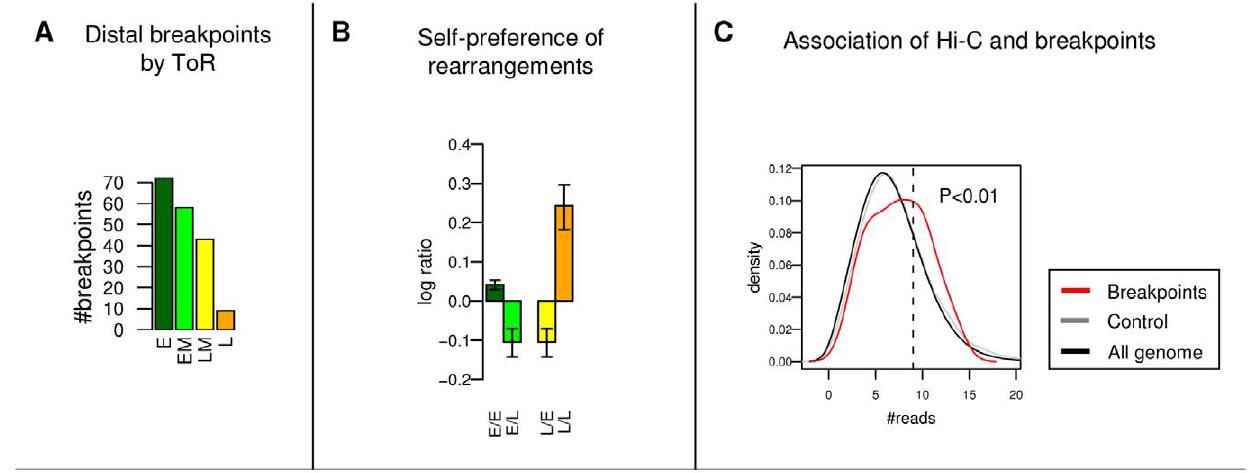
Figure 5. ToR and Hi-C preferences of distal rearrangements. (A) Distal fusion events involve early replicating domains. Each distal murine fusion event (inter-chromosomal or spanning at least 5MB in all non-rodent species) is associated with 2 human ToR groups (of the two segment ends that got fused). We show the breakdown of fusion events according to ToR groups. (B) Distal fusion events bring together domains with similar ToR. We split the genome to two equal groups (E:early, L:late), and counted for all murine distal fusions the number interaction of all possible pairs (E- E, E-L, L-L). We show the ratio between the counts and a random control (log 10 scale), showing a significant preference for fusions of the same ToR group. (C) Distal fusion events are enriched for Hi-C interactions. We focused on murine distal fusion event that involves a pair of human sites that reside on different chromosomes. For each pair we counted the number of Hi-C interactions in the human genome (between segments of 1Mb centered on the breakpoint), which reflects chromosomal proximity. As a control we shuffled the pairs, getting random pairs of sites in the human genome that reside on different chromosomes. Using 75% as a threshold (dashed line), we tagged each pair as interacting (1st quartile) or non- interacting (other quartiles). Breakpoints are enriched in the interacting group (1.6 enrichment and P , 0.01 in a Hyper geometric test). Shown are density plots of the number of reads between mouse fused pairs (red), between the shuffled control pairs (grey), and between a collection of random pairs selected over all of the genome